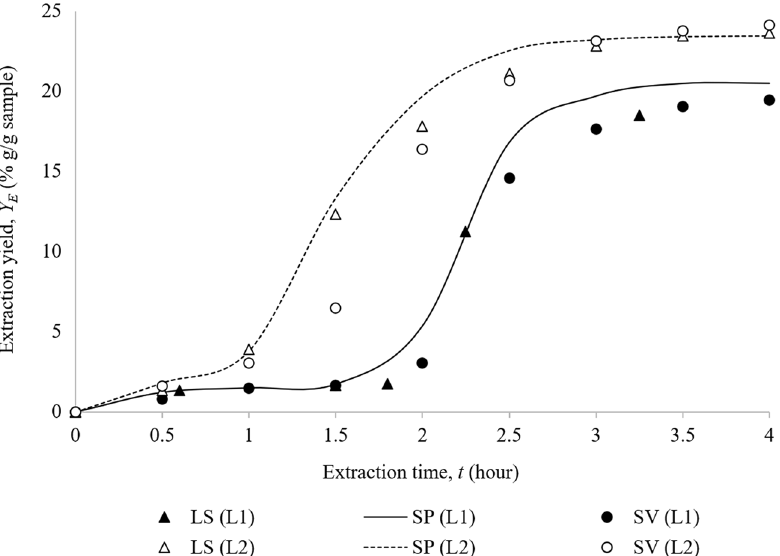
Figure 3. Comparison of OEC for laboratory-scale experiment (LS) with OEC for scale-up prediction (SP) and scale-up validation experiment (SV) at L1 and L2. LS and SP data were obtained from previous study 32 . L1: P = 200 bar, T = 60 °C, co-solvent = 50% ethanol–water with 10% (v/v) concentration, L2: P = 262 bar, T = 80 °C, co-solvent = 30% ethanol–water with 13% (v/v) concentration.